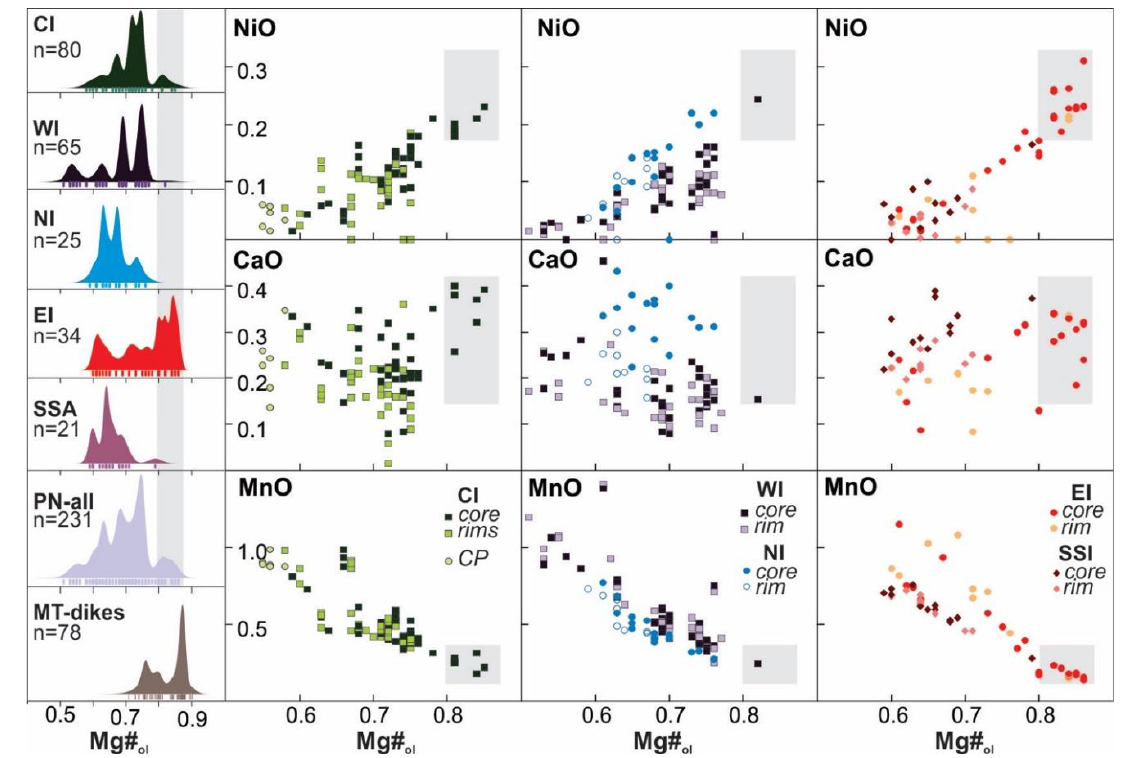
Figure 6. Olivine compositions of the Ponte Nova mafic – ultramafic alkaline massif. Kernel density estimates (KDEs; bandwidth = 0.01) of olivine Mg# distribution for each of the main intrusion of the massif. Interestingly, the main cluster is associated with almost unzoned, cumulatic olivine crystals, with Mg# below 0.77. Another group (gray bar) is found for zoned olivine crystals with Mg# > 0.8. Zoned olivines are similar to the main group found for antecrysts in the Mantiqueira Range dikes (MT-dikes).